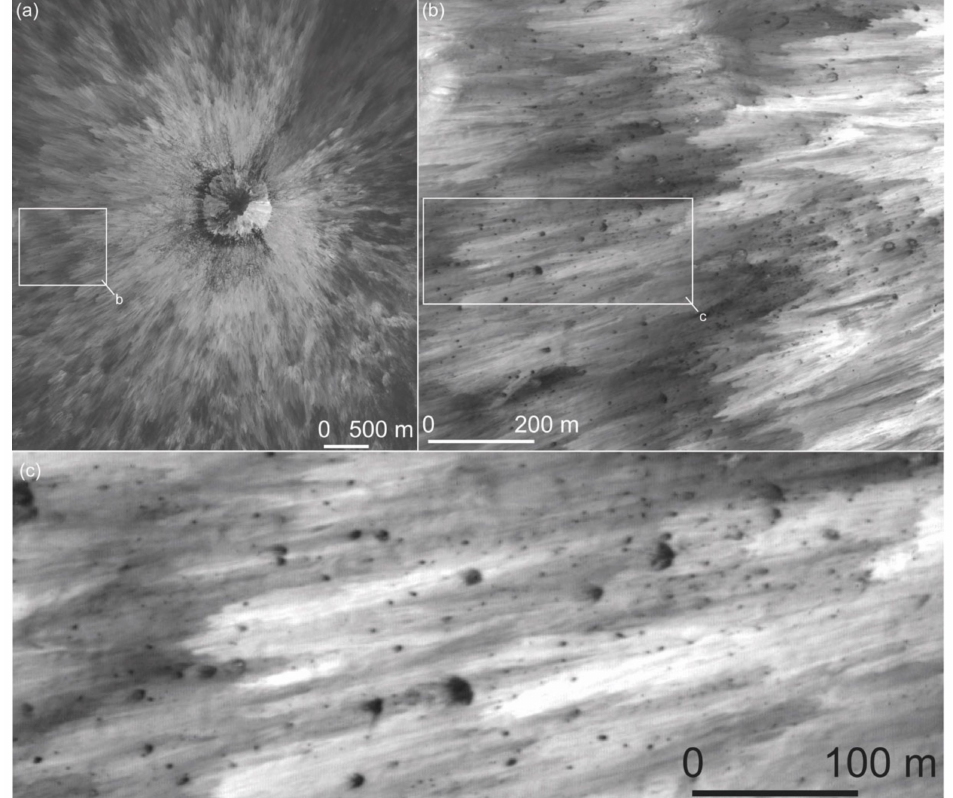
Figure 3. Heterogeneous distribution of craters on the ejecta deposits of a cold spot crater ( D = 898 m), which is centered at 90.76 ◦ E, 5.39 ◦ S. North is up in all the panels. ( a ) The cold spot crater is produced by an oblique impact coming from the northeast. ( b ) An area on the western ejecta deposits features abnormally high density of superposed craters compared to adjacent ejecta. The location is marked in panel ( a ). ( c ) Detailed view of highly clustered craters on the ejecta flows, and the small craters have penetrated through the high-reflectance ejecta, exposing subsurface lower-reflectance regolith. The location of this frame is annotated in panel ( b ). IDs of data used in this figure are compiled in the Supplementary